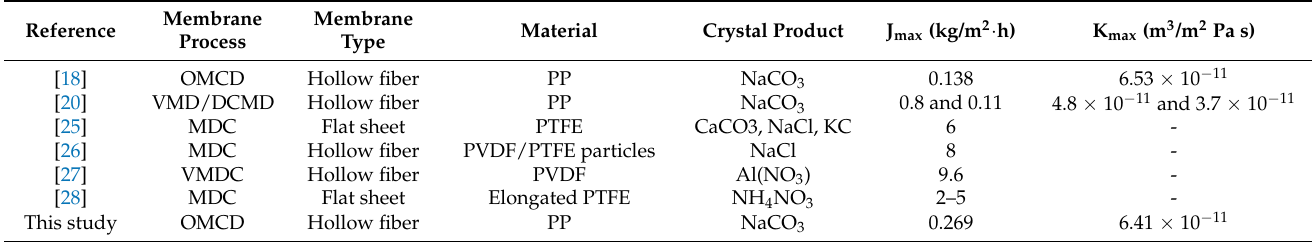
Table 2. Comparison of performance of previous membrane crystallization processes with the process in this